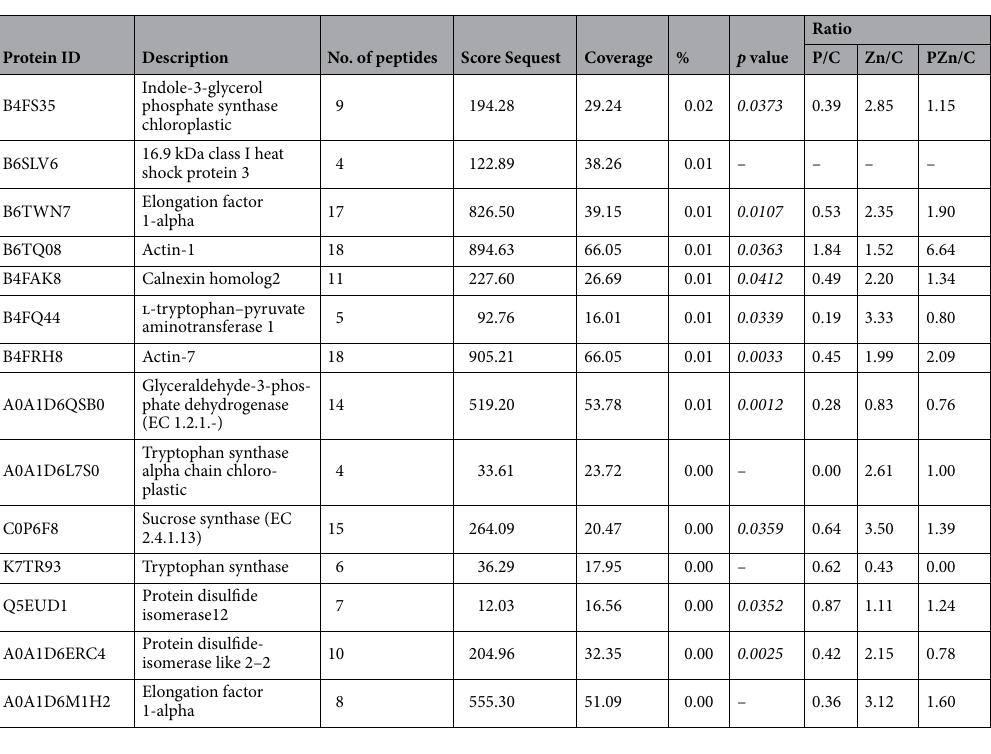
Table 4. List of differentially accumulated proteins altered by the presence of P and Zn in mature grains as grouped by most abundant proteins, seed storage proteins and trp- and lys-rich proteins. DAPs were determined according to statistically significant changes between samples by ANOVA ( p < 0.05) and fold ≥ 2 or ≤ 0.5. The ID, description, number of peptides (≥ 2), score (≥ 2) and coverage (≥ 15%), relative abundance (%), p (< 0.05) and ratio (fold ≥ 2 or ≤ 0.5) of each protein are shown. The relative abundance (%) was calculated from the combined abundance of all treatments for each protein divided by the combination of proteins included in each treatment. The most abundant proteins, seed storage proteins and trp- and lys-rich proteins are listed in Table S4. Italics are used to differentiate the p values. Qualitative DAPs did not show p value data and qualitative DAPs without protein abundance in the control treatment did not show relative abundance data. C : no P or Zn was added; P : fertilization with 40 mg P kg −1 but no Zn; Zn : fertilization with 3 mg Zn kg −1 but no P; PZn : fertilization with 40 mg P kg −1 and 3 mg Zn kg −1 . na: